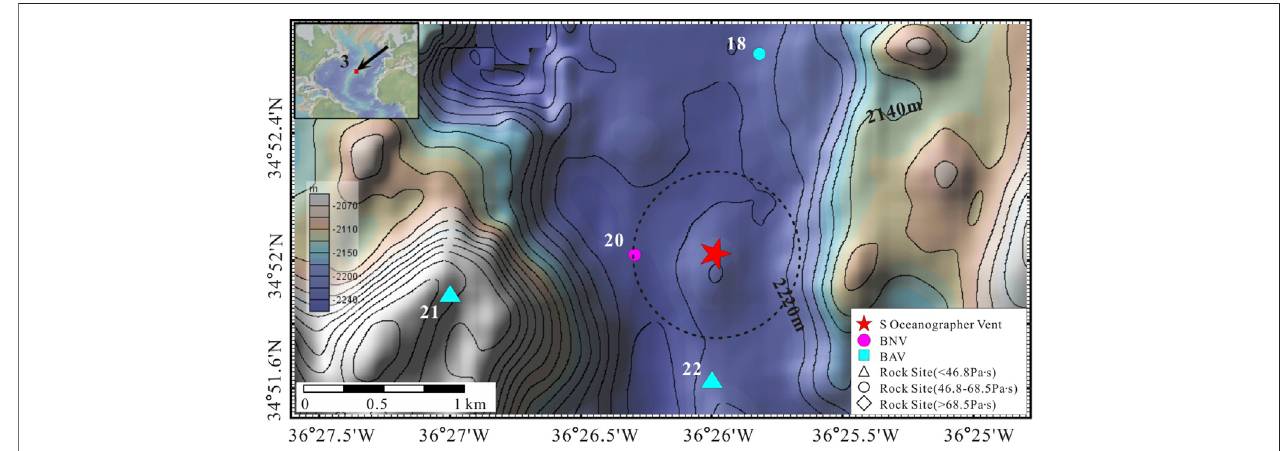
FIGURE6| BathymetricmapfromGeoMapApp,showingthelocationsoftheSOceanographer ventand thesamplesites. Blacksolidlines arethe20 misobaths. The symbols and color bar are described in the caption of Figure 3 .